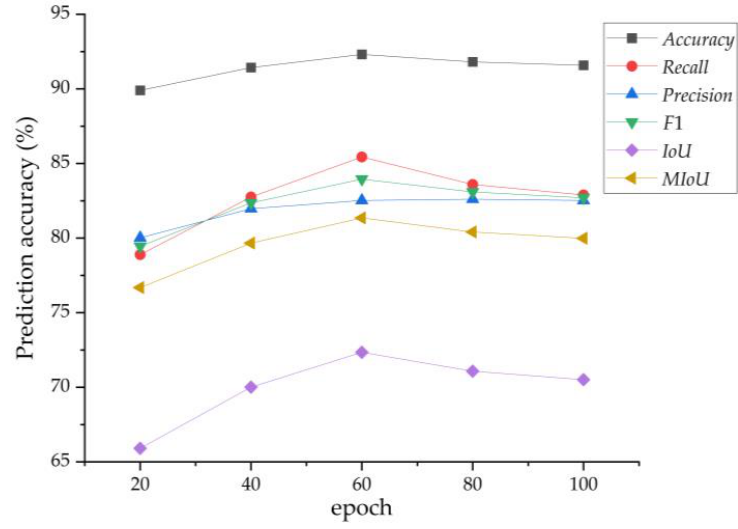
Figure 10. Comparison of prediction accuracies at different training epochs.